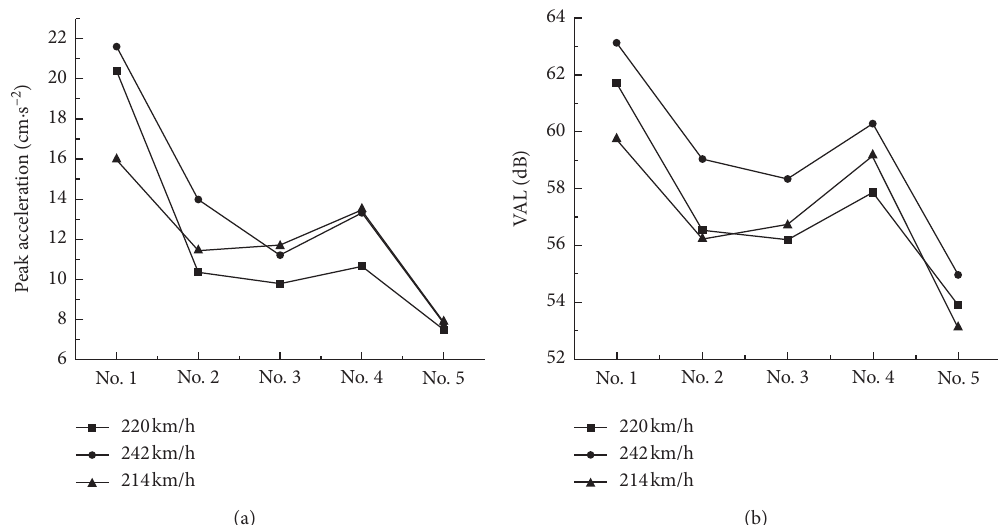
Figure 9: Peak acceleration in Z direction and VAL at five test points as a function of train speed. (a) Peak acceleration. (b) Vibration acceleration level.